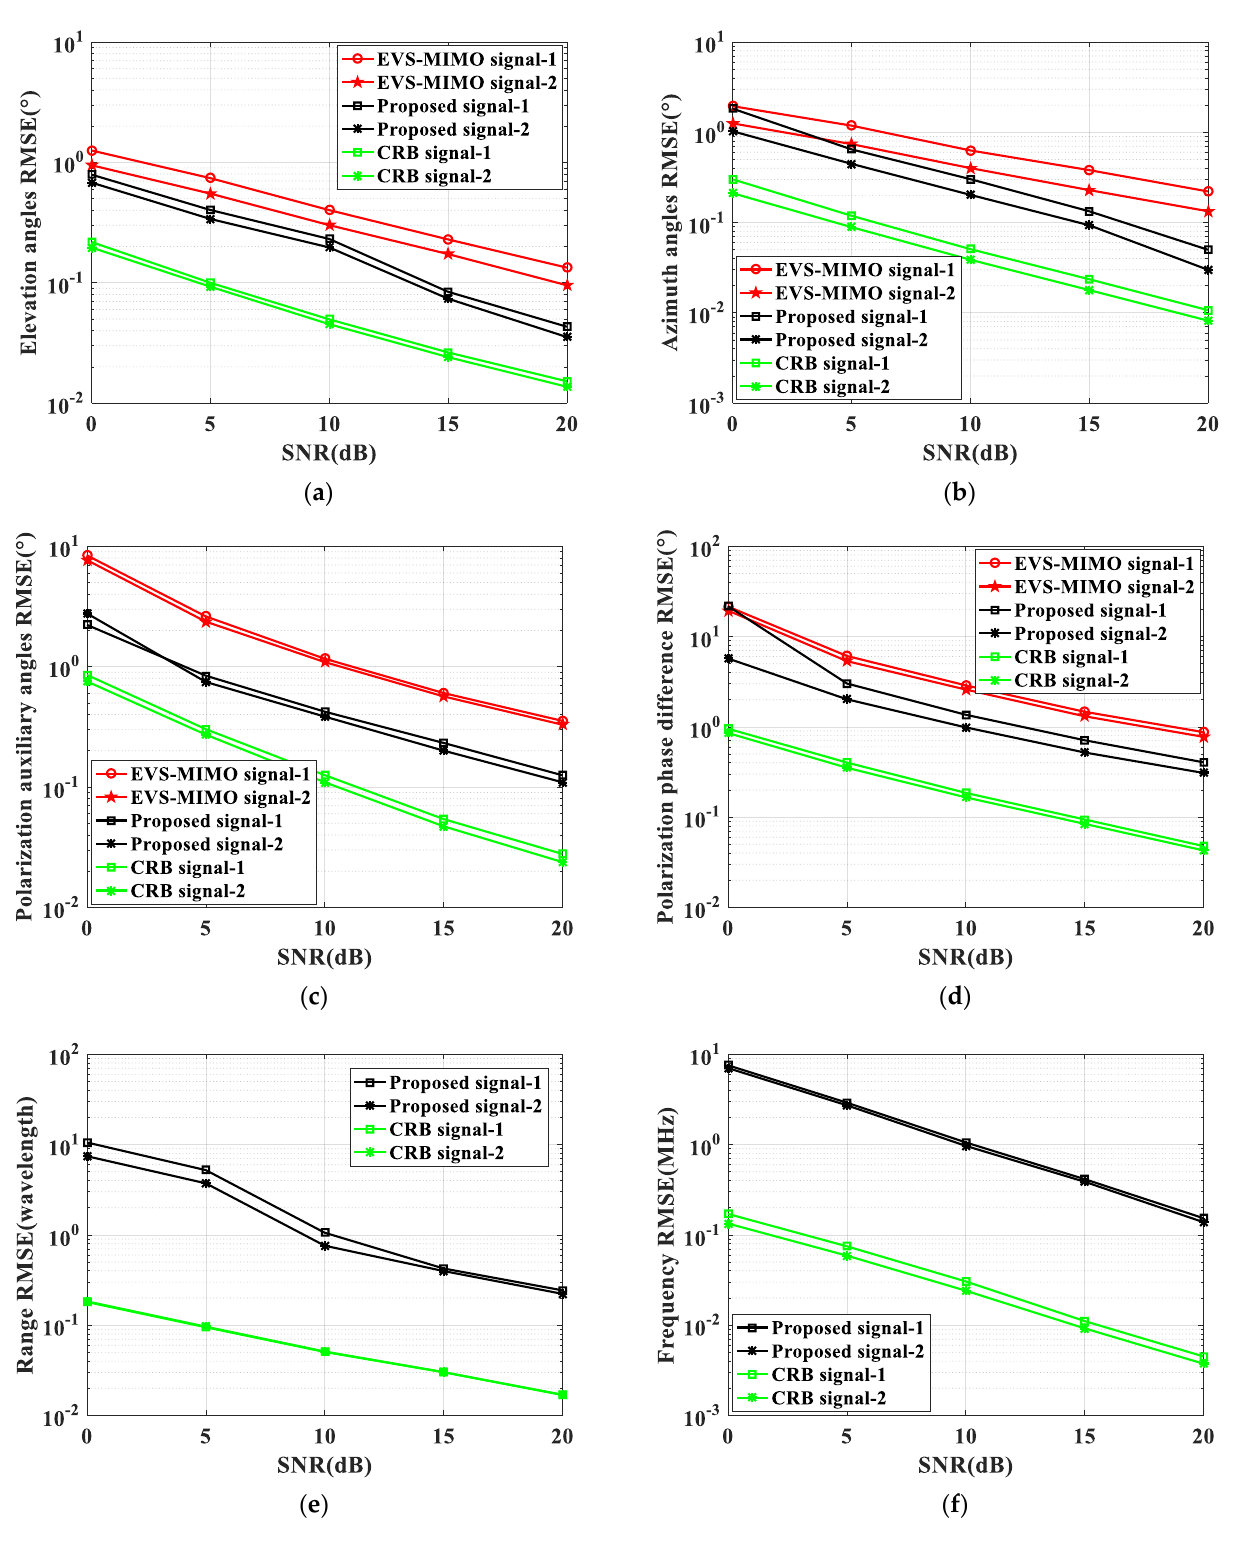
Figure 2. RMSE of the parameter estimation for NF sources with respect to different input SNRs: snapshot number = 1000, ( f 3 , r 3 , ϕ 3 , θ 3 , γ 3 , η 3 ) = ( 5 MHz,2 λ ,10 ◦ ,30 ◦ ,40 ◦ ,70 ◦ ) , ( f 4 , r 4 , ϕ 4 , θ 4 , γ 4 , η 4 ) =